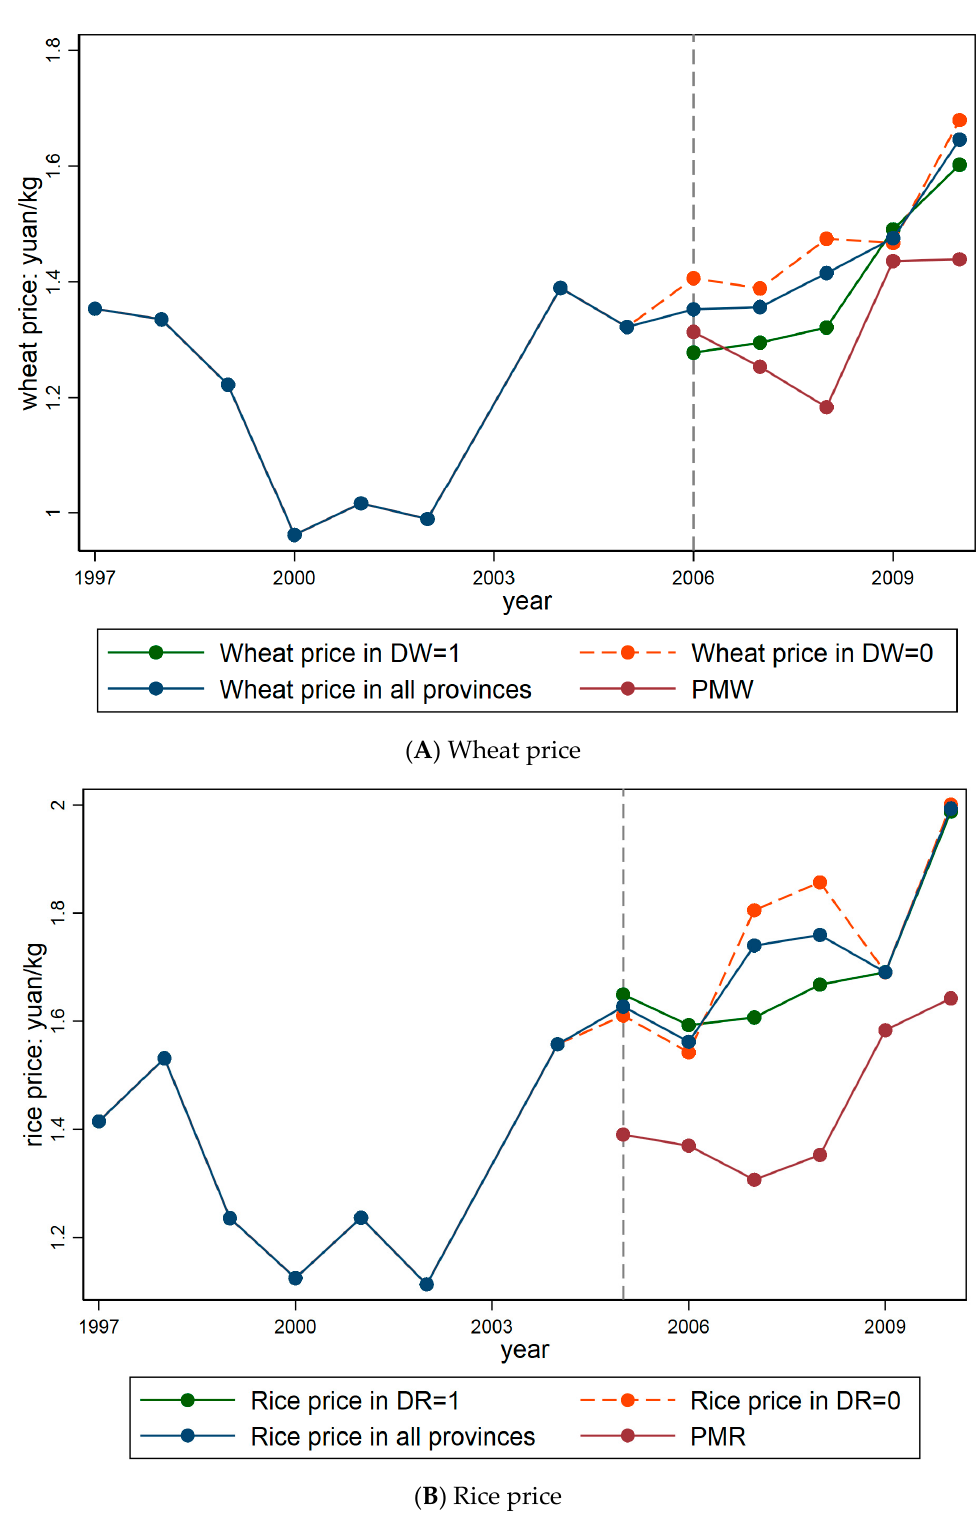
Figure A1. Trends of average price for ( A ) Wheat and ( B ) Rice; In yuan/kg; All prices have been deflated to 1997 prices, using national consumer price index data. Source: Calculated from the RFOP survey data set 1997–2010 combined with [3].